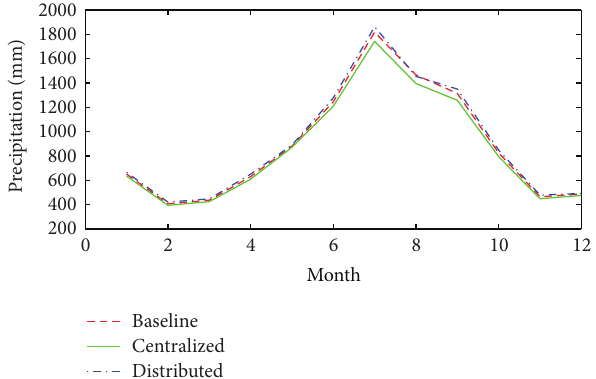
Figure 7: Precipitation under different scenarios.